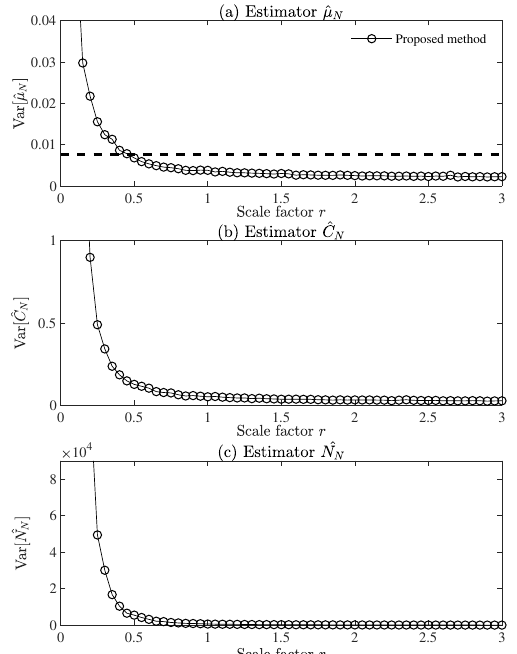
Figure 8. Estimating the variance of the estimates ˆ µ N , ˆ C N , ˆ N for various scale factors r of the proposed method.